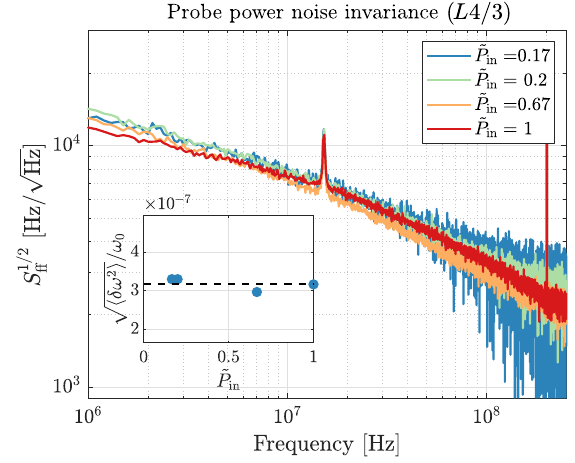
FIG. 3. Comparison of corrected L 4 = 3 cavity frequency noise ˜ P normalized to the maximum spectra at various input powers in value for the dataset. The rms fractional frequency fluctuation ffiffiffiffiffiffiffiffiffiffiffiffi p = ω 0 is computed from the integrated noise over the h δω 2 i plotted measurement bandwidth and plotted in the inset as a ˜ P function of . No significant power scaling or deviation from in the mean value (black dashed line) is observed, indicating that noise contributions from nonlinear effects can be